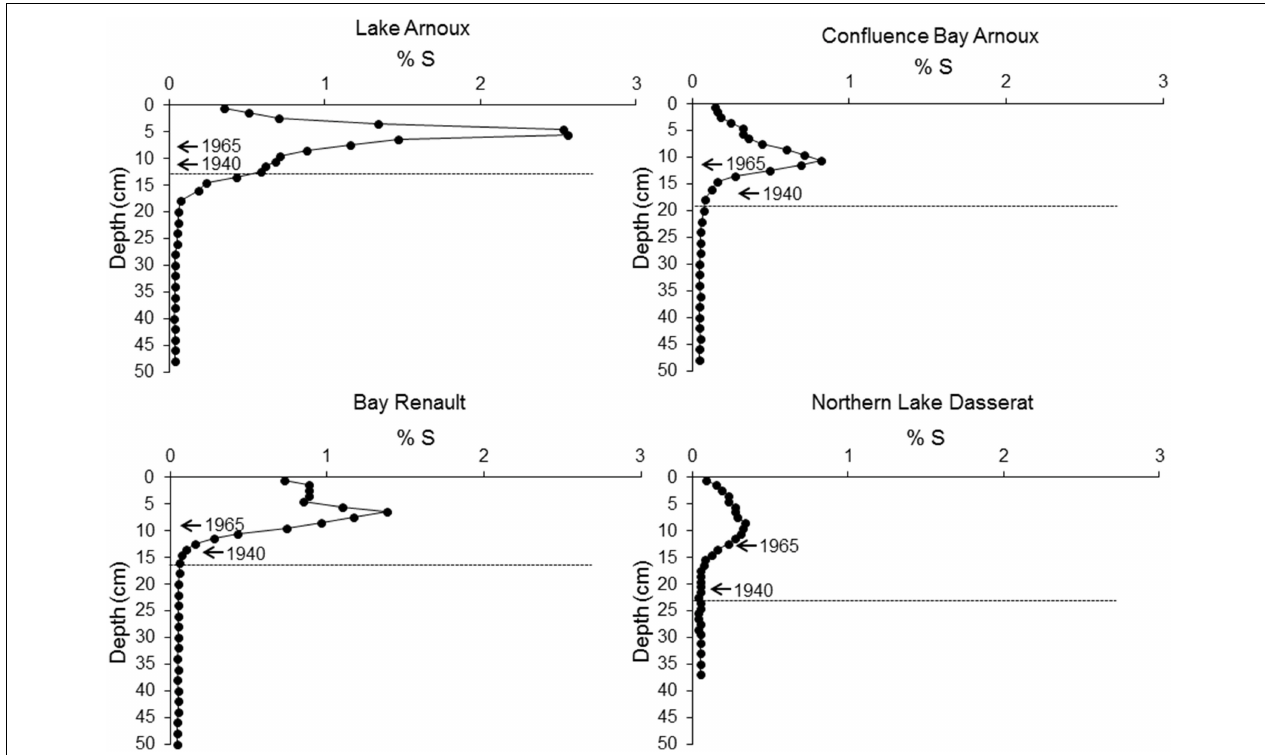
FIGURE 4 | Profiles of total percent sulfur concentrations in sediments for each of the four cores. 210 Pb dates aligned with sediment depth are presented with arrows. The dotted line corresponds to the pre-mining period based on sedimentation rates determined with 210 Pb data.